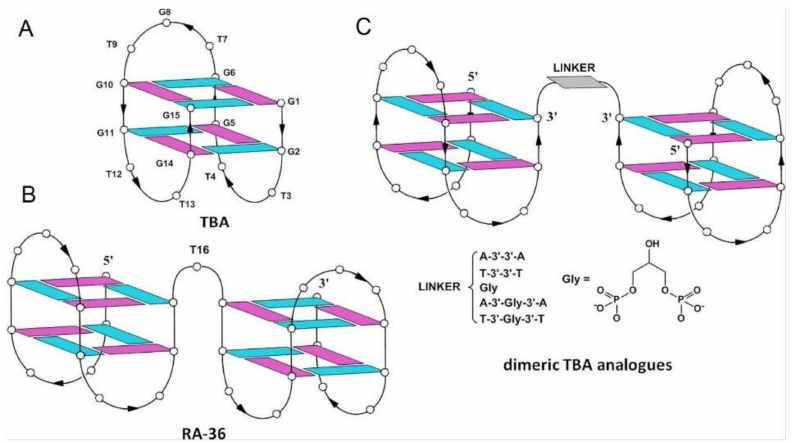
Figure 12. The structure of TBA ( A ), RA-36 ( B ) and bivalent aptamer composed of two HD1 domains (connected via different linkers) ( C ) [64]. Reproduced under the Creative Commons Attribution